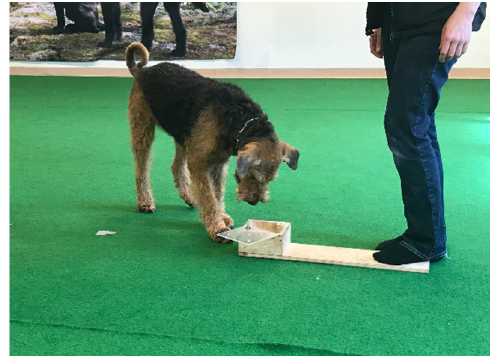
Figure 3. Test setup during the training phase of the unsolvable task. The lid is open, allowing the dog to easily access it. The box was then placed in front of the dog again, and the dog was released. For 2 min, the dog was allowed to move freely around the room and manipulate the box. The owner was advised to stay quiet and only look at the box, and the experimenter did the